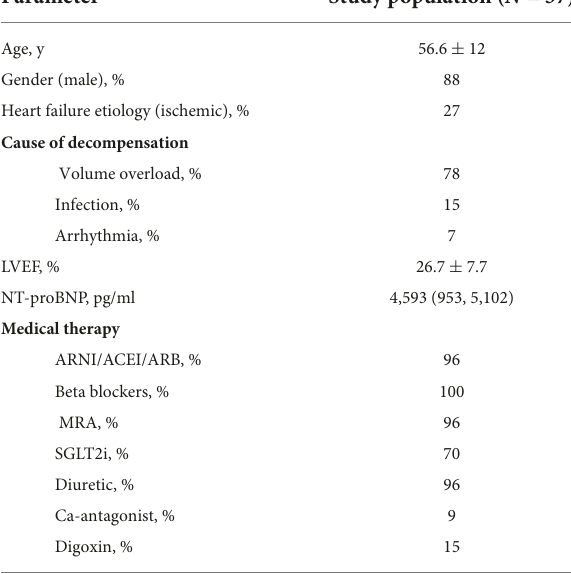
TABLE 3 Patient clinical